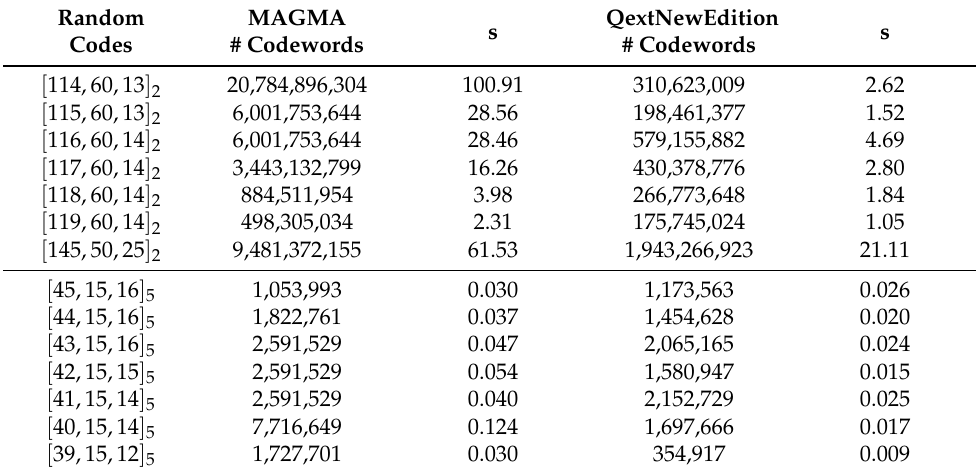
Table 1. Minimum weights of [ n , k , d ] q linear